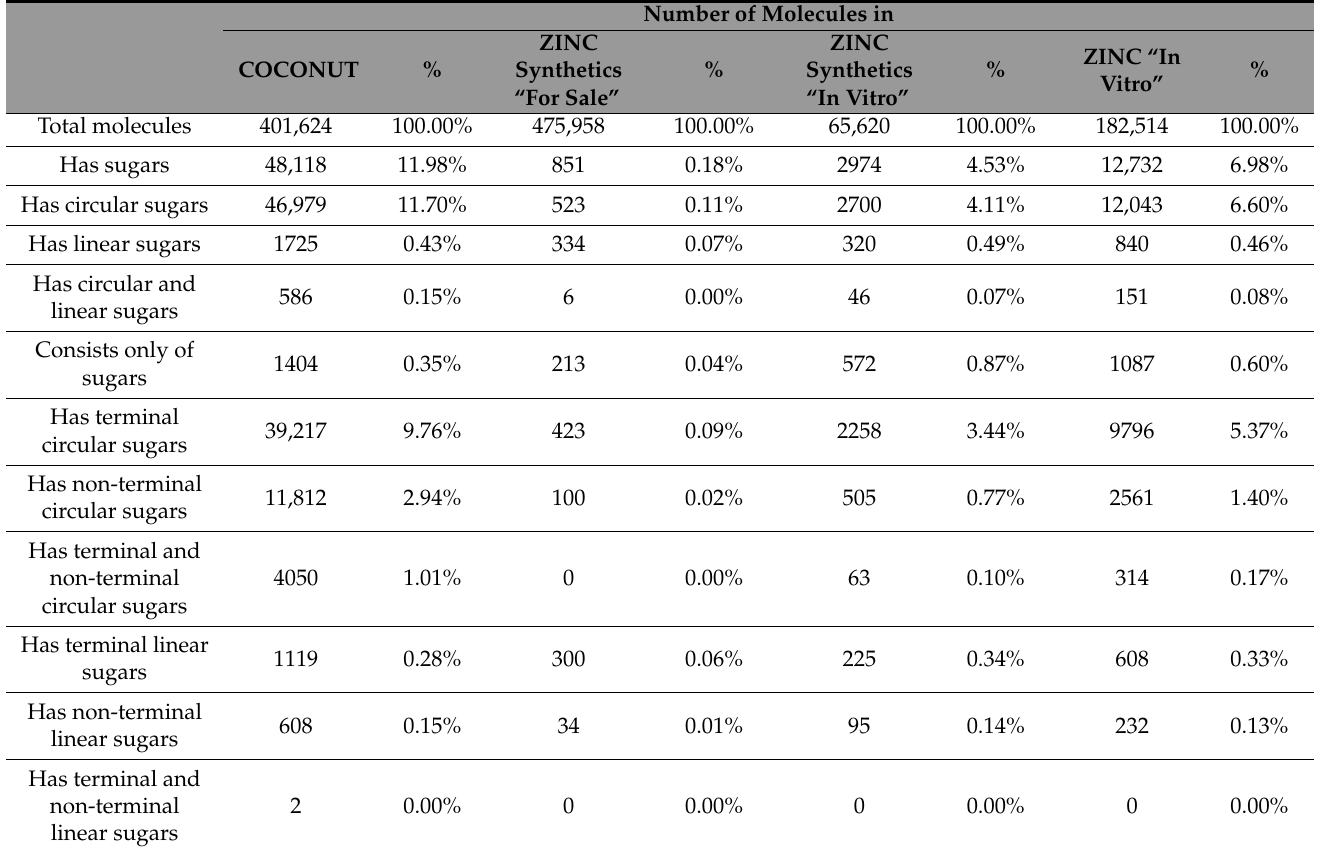
Table 3. Summary of glycosylation analysis results on ZINC datasets and comparison with COCONUT. Number of Molecules